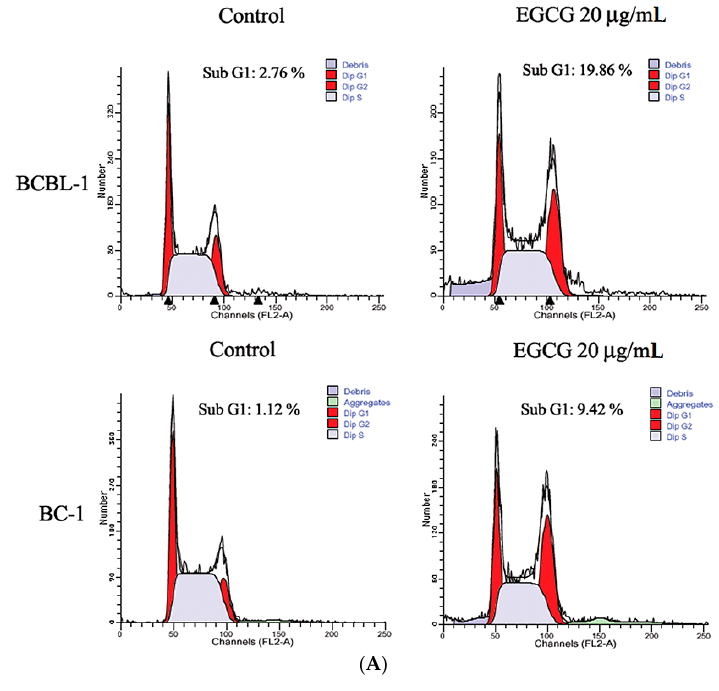
Figure 1. Epigallocatechin-3-gallate (EGCG) reduced cell viability in human herpesvirus 8 (HHV8)-harboring primary effusion lymphoma (PEL) cells. ( A ) PEL cells (BCBL-1 and BC-1) were treated with EGCG at the concentrations indicated for 24 h; ( B ) Sensitivity of BCBL-1, BC-1, BJAB cells and PBMCs to EGCG. BCBL-1, BC-1, BJAB cells and PBMCs were treated with 20 μ g/mL of EGCG for 24 h. Cell viability was determined by the trypan blue exclusion assay. The cells in supplemented medium were used as a control. The values represent mean ± SE of three independent experiments and are presented as the percentage of the control. * p < 0.05 and ** p < 0.01 indicate significant differences between the control and EGCG-treated cells.